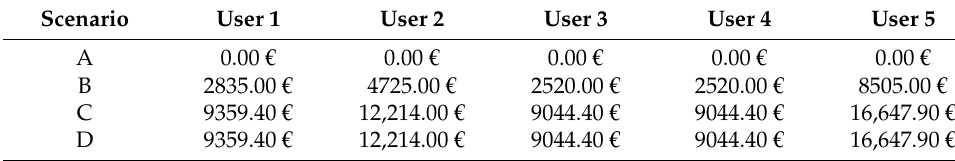
Table 4. Total facility-investment costs per prosumer and study